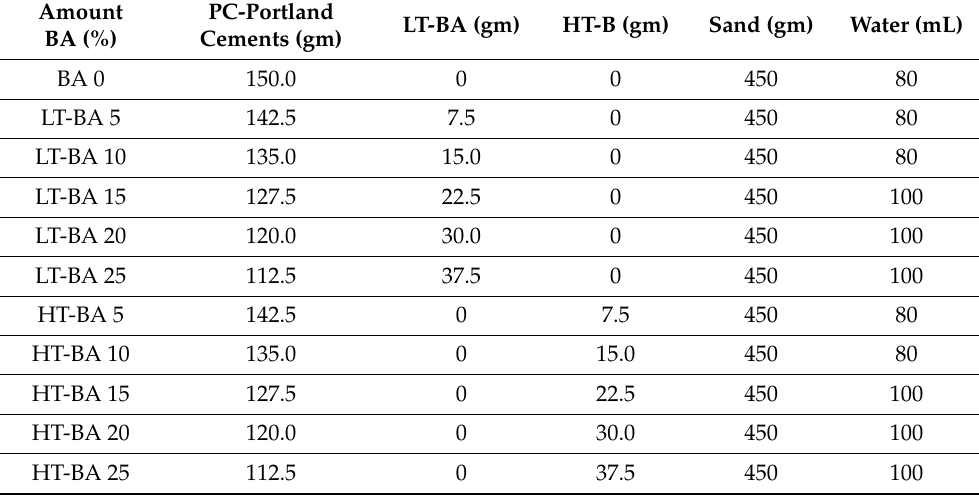
Table 2. Mixing proportion of BA-blended PC mortars, Cement : Sand = 1 : 3.